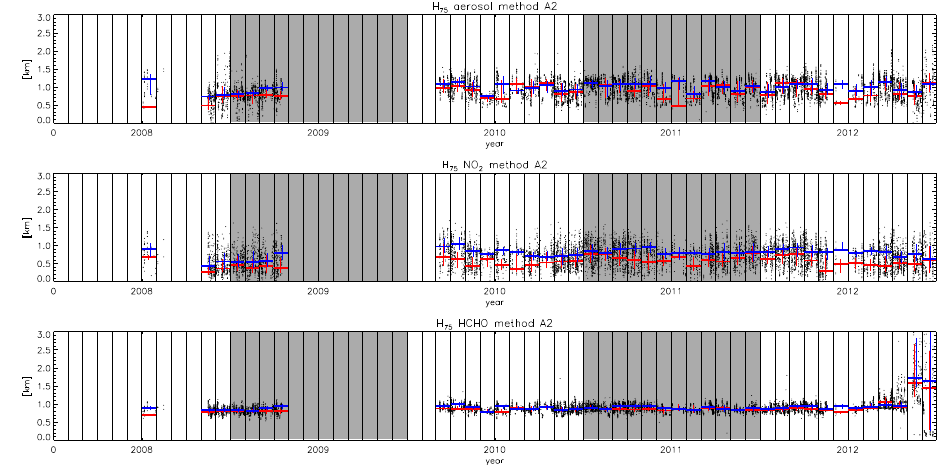
Figure 12. Time series of individual data points and monthly medians of profile heights ( H 75 ) for aerosol (Vis), NO 2 and HCHO obtained with method A. The black dots refer to individual profiles. The red and blue lines refer to monthly medians for the morning (all observations before 10:00a.m.) and afternoon respectively (all observations after